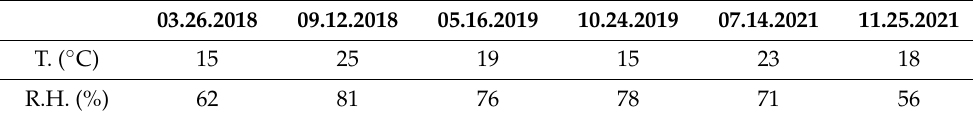
Table 7. Temperature and relative humidity taken at different